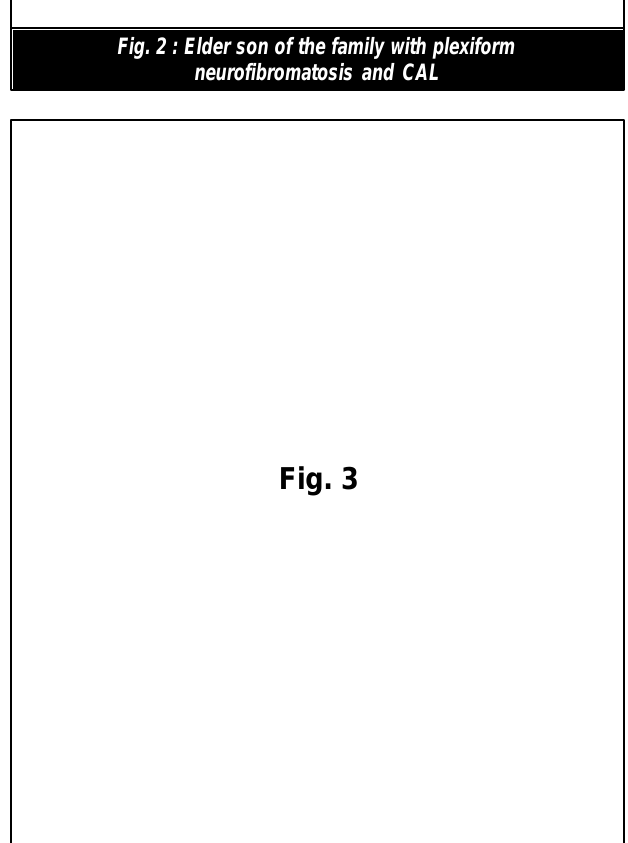
Fig. 2 : Elder son of the family with plexiform